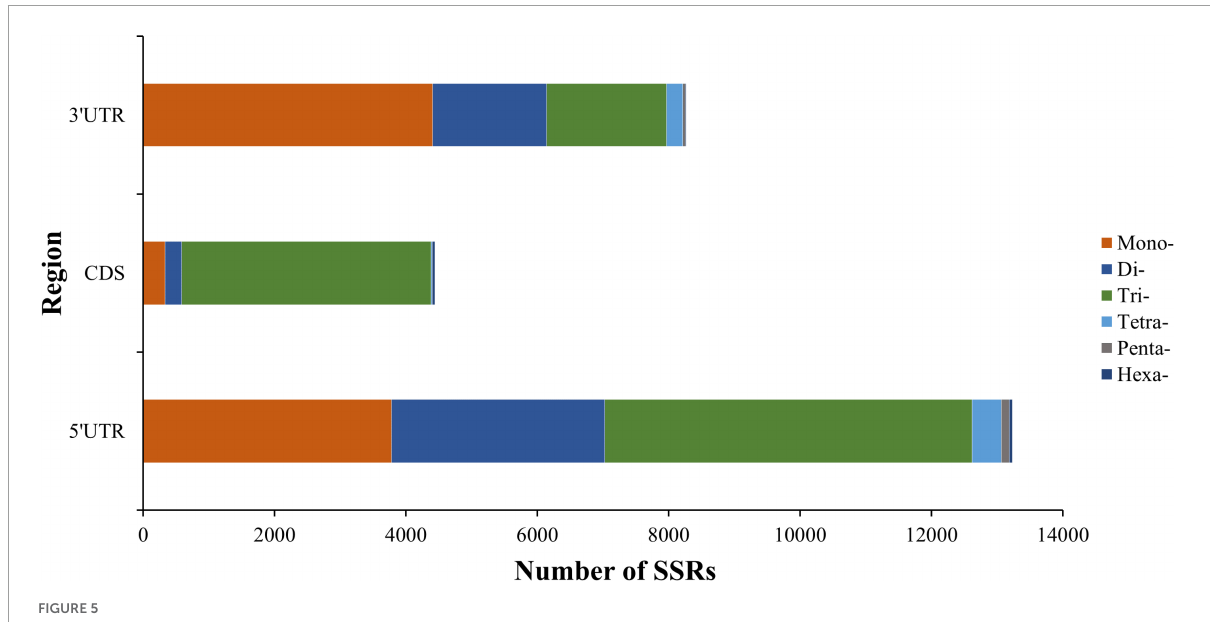
FIGURE5 Distribution of six SSR repeat types in different genic